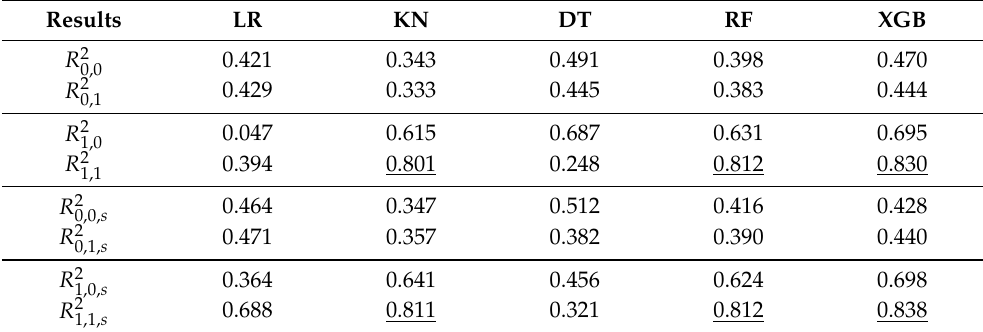
Table 2. Results of COVID-19 cases prediction.